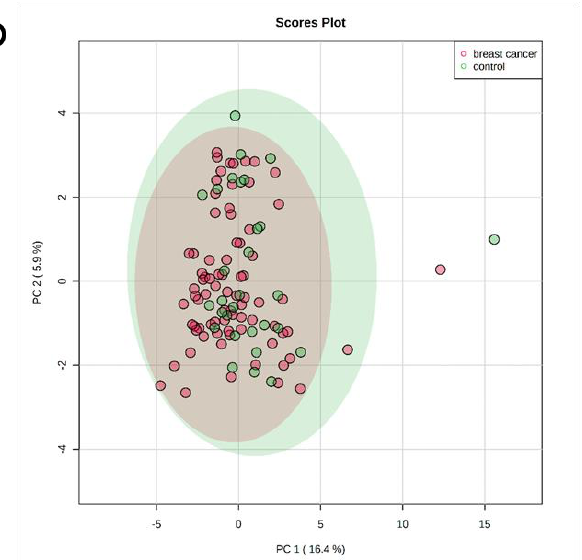
Figure A2. Metabolic profiles of controls and breast cancer patients show no difference in ( a ) the heatmap cluster or ( b ) principal component analysis.